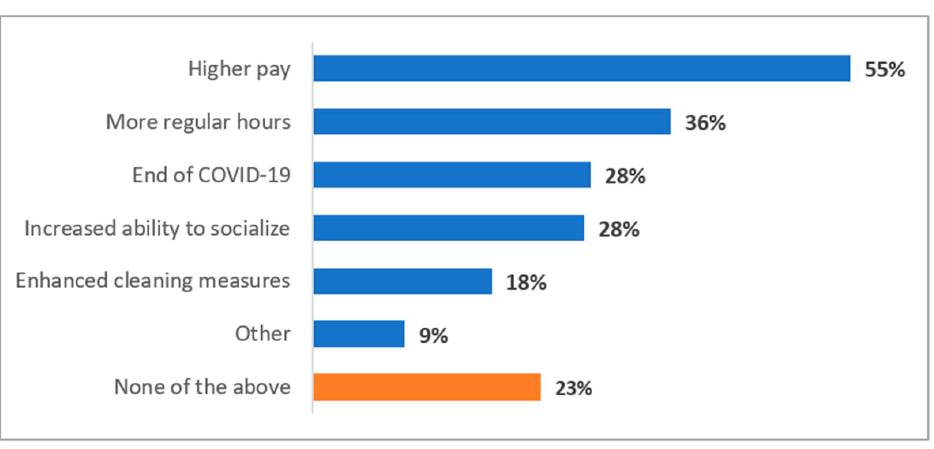
Figure 9. Tourism industry incentives ( n = 159).